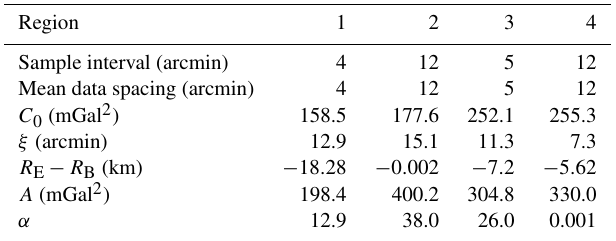
Table 3. Statistics of gravity anomalies before and after removing GGM and RTM effects (mGal). Region 1 2 3 4 Remove Before GGM RTM Before GGM RTM Before GGM RTM Before GGM RTM Min − 50 . 2 − 158 . 0 − 46 . 3 − 75 . 7 − 153 . 9 − 39 . 0 − 152 . 3 − 95 . 2 − 75 . 2 − 94 . 1 − 82 . 7 Max 191.7 116.1 Mean 38.66 − 17 . 94 − 7 . 21 15.71 − 31 . 18 SD 33.85 Table 4. Percentage of removing GGM and RTM effects on the SD of the gravity signal in each region. Region 1 2 3 4 Remove mGal Percent mGal Percent mGal Percent mGal Percent GGM 11.4 18.9 RTM GGM + RTM 24.0 56.2 Data Distribution Dense Sparse Dense Sparse Topography Smooth Rough Rough Smooth